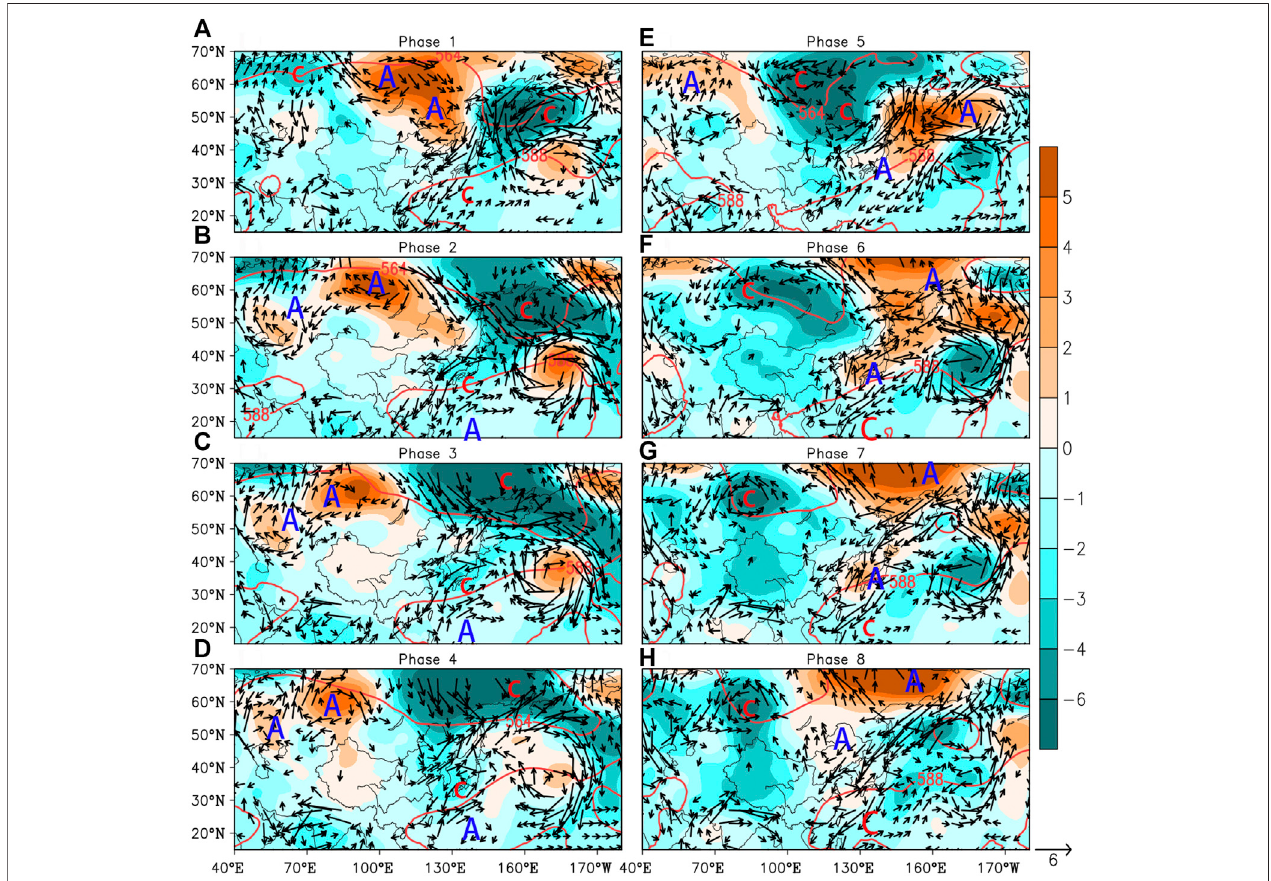
FIGURE11| Asin Figure9 butfor fi fthandsixthrainfallprocesses. A-H correspondtotheeightphasesofthecompositeevolutionofQWBOcomponentofthethe second to third rainfall processes.